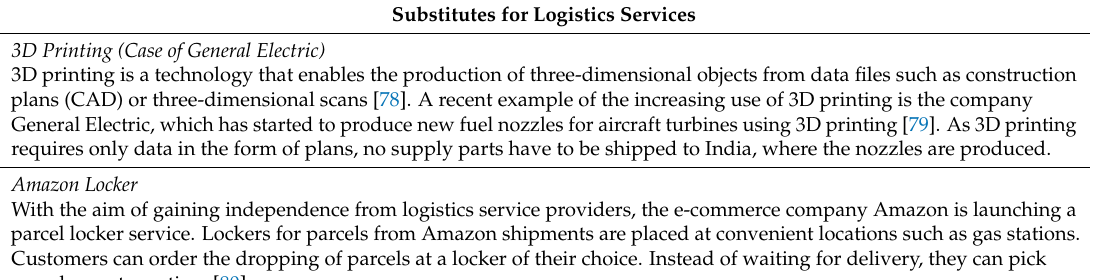
Table 8. Practical examples of substitutes for logistics